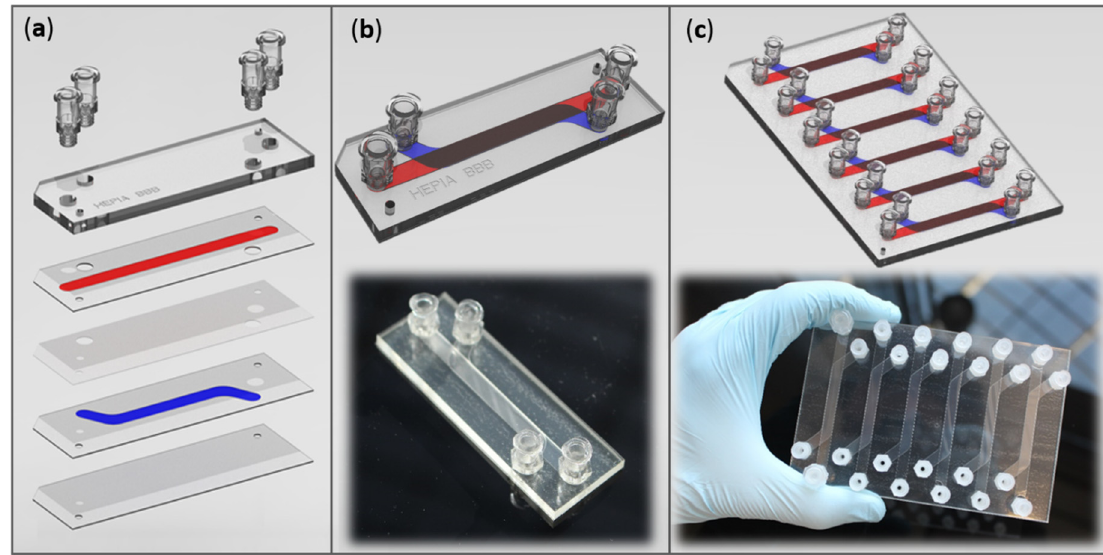
Figure 1. Fluidic barrier device representations. ( a ) Exploded view of the different parts of the barrier device before assembling. ( b ) Pictures and 3D representations of our home-made barrier device in microscope slide format and ( c ) in plate format (encompassing six conditions in parallel). The upper channel is represented in red, and the lower one in blue. Device modelling was carried out with PTC Creo software.